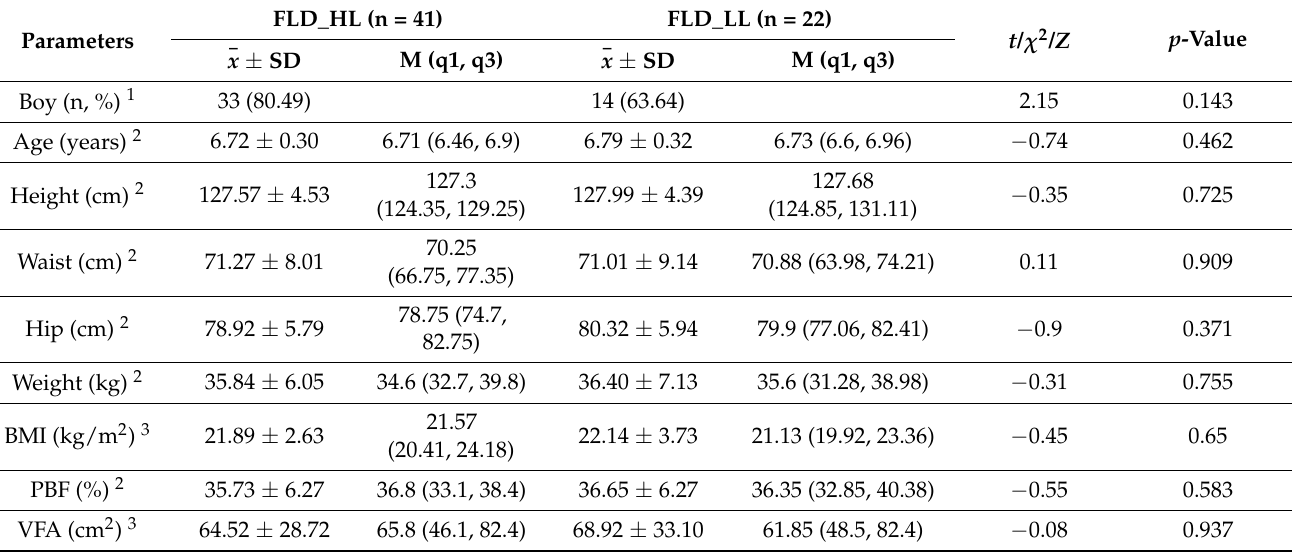
Table 2. Comparison of clinical indicators between groups FLD_HL and